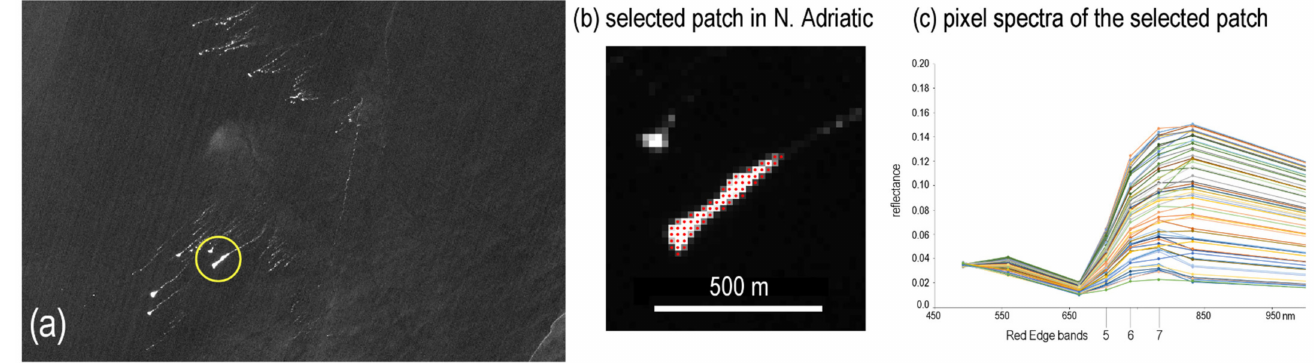
Figure 12. ( a ) Floating patches detected in North Adriatic on 21 August 2021 (Sentinel-2 tile: 33TUL, western edge). ( b ) Selected patch in band 8 and ( c ) relative pixel